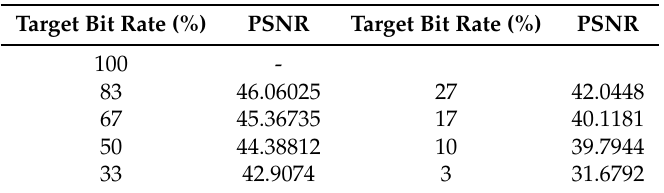
Table 1. Target bit rate vs. PSNR.